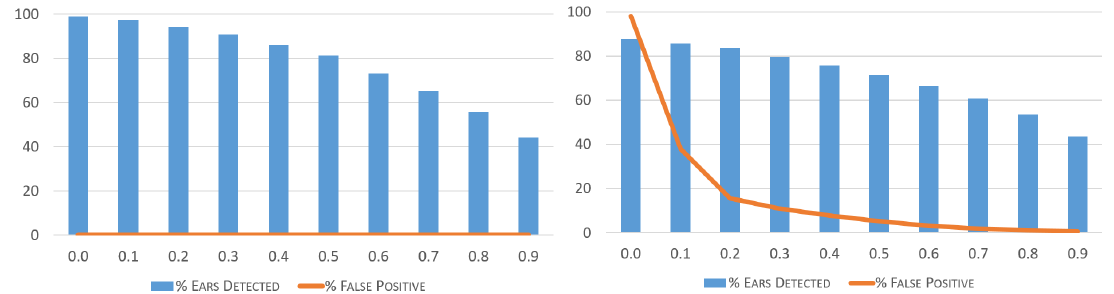
Figure 10. Threshold sensitivity on ear detections: ( Left ) AMI Dataset Detections, ( Right ) UBEAR Dataset